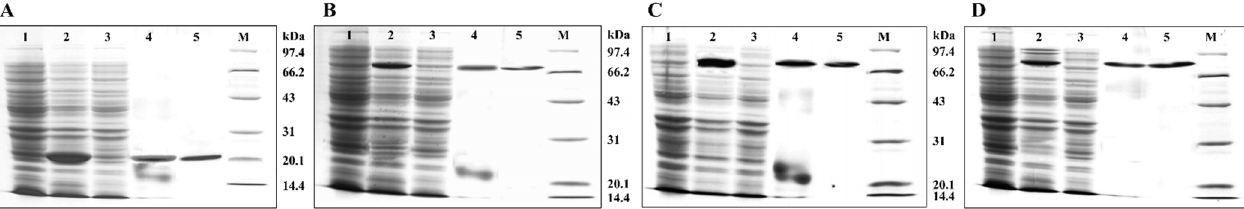
Figure 4. SDS ‐ PAGE analysis of recombinant protein for AglaHsp20.43 ( A ), AglaHsp71.18 ( B ), AglaHsp82.09 ( C ), and AglaHsp89.76 ( D ). Channels 1, 2, 3, 4, and 5 represent the bacterial culture